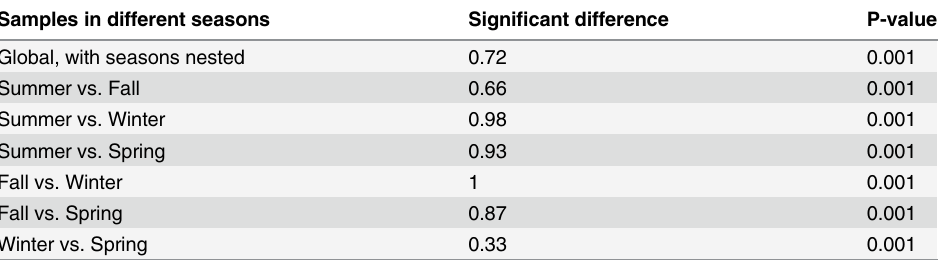
Table 1. Analysis of Similarity Statistics (ANOSIM) test for significant differences between quarterly groupings in AS overall microbial community compositions. A priori grouping strategy was based on the result of principal coordinates analysis